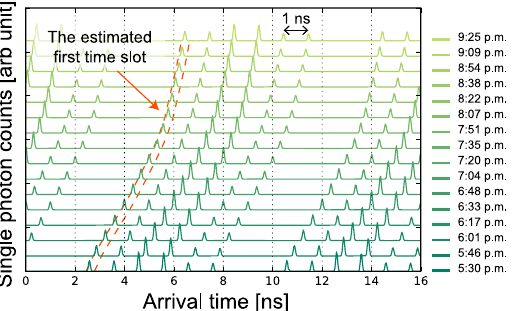
Figure 2. Result of photon detection time tracking. Histograms of single photon counts in long-time measurements at SNSPD 2 for Alice are shown. Single photon counts were accumulated in one minute for each histogram. The photon detection time drifted about 4 ns during the measurement, which was longer than the total duration of the four-dimensional time-bin